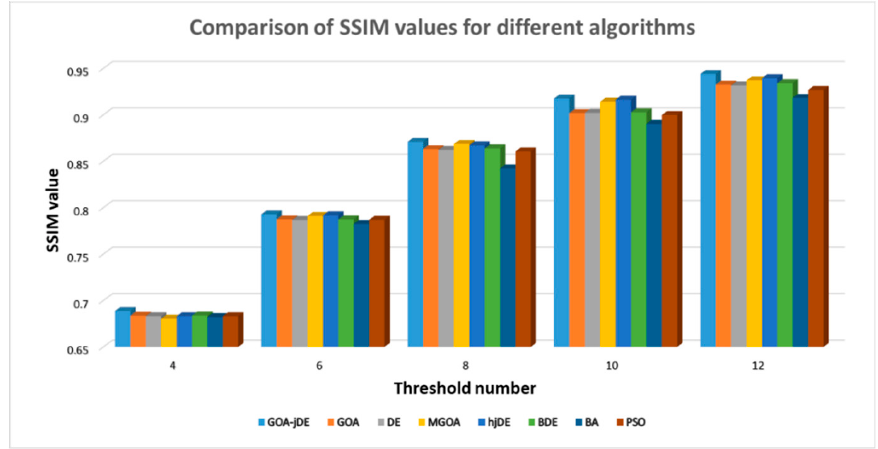
Figure 9. Comparison of SSIM values over all images using MCE method at 4, 6, 8, 10, and 12 levels.